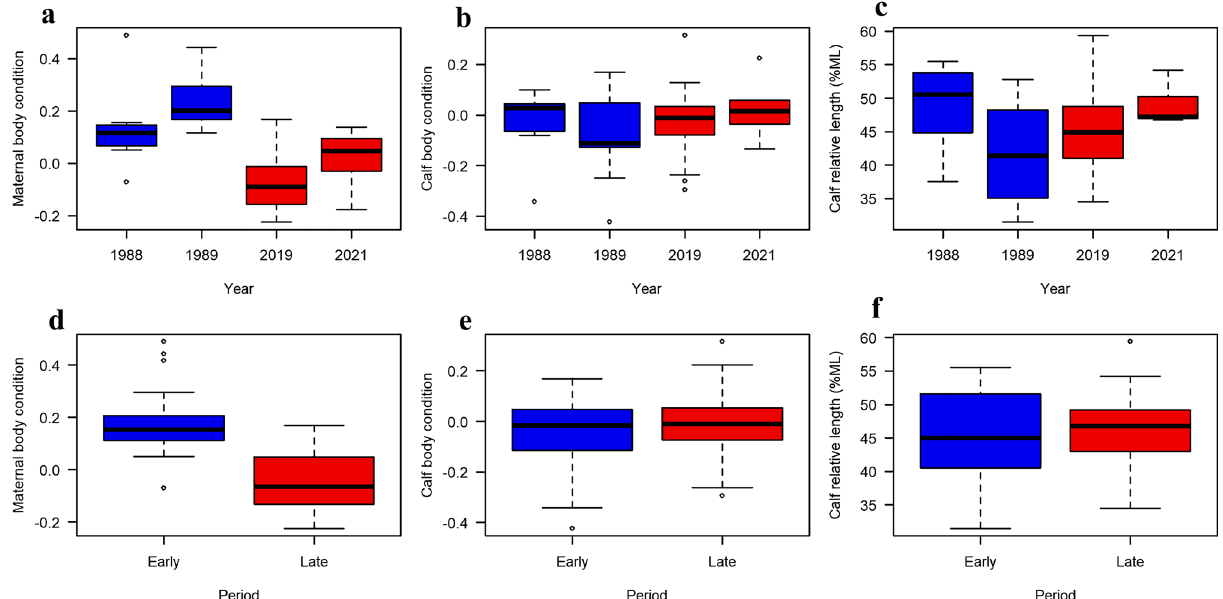
Figure 2. Boxplots showing the observed variation in body condition and length. ( a and d ) show the observed variation in maternal body condition, whereas ( b and e ) show the variation in calf body condition, and ( c and f ) show the variation in calf relative body length of southern right whales for the different sampling years (top row) and periods (bottom row). The blue and red colours indicate measurements taken during the early and late periods, respectively. ML maternal body length. For sample sizes, see Table